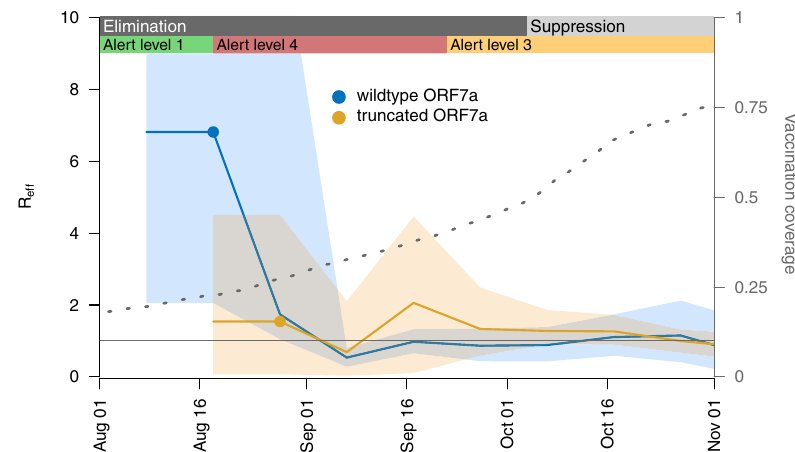
Fig. 4 Estimates of the effective reproduction number (R eff ) over time. Mean estimate of the effective reproduction number (R eff ) over time (solid line) and its 95% credible interval (shaded area), based on genomes with the truncated (orange) or wildtype (blue) ORF7a. One R eff estimate is made per 10- day period following detection of the fi rst community case ( fi lled circle) for either lineage, plus one additional estimate between this period and the fi rst transmission event (i.e. the root of the tree). The right axis shows the proportion of the eligible population (12 + years old) who had received two doses of the P fi zer-BioNTech COVID-19 vaccine. The nationwide change from elimination to suppression strategy is indicated, as are regional changes